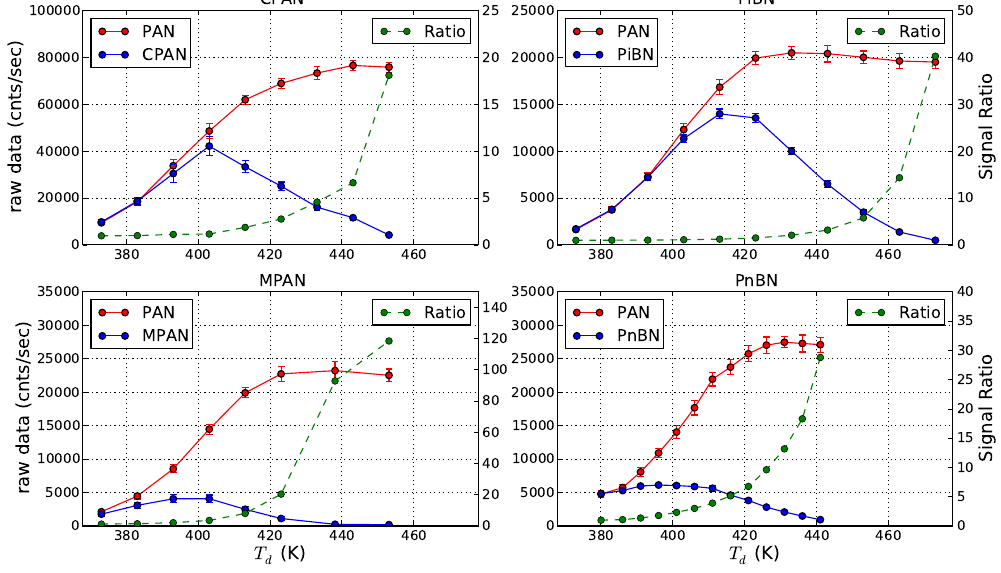
Fig. 6. The variation of C 4 -PAN compound signals as a function of T d